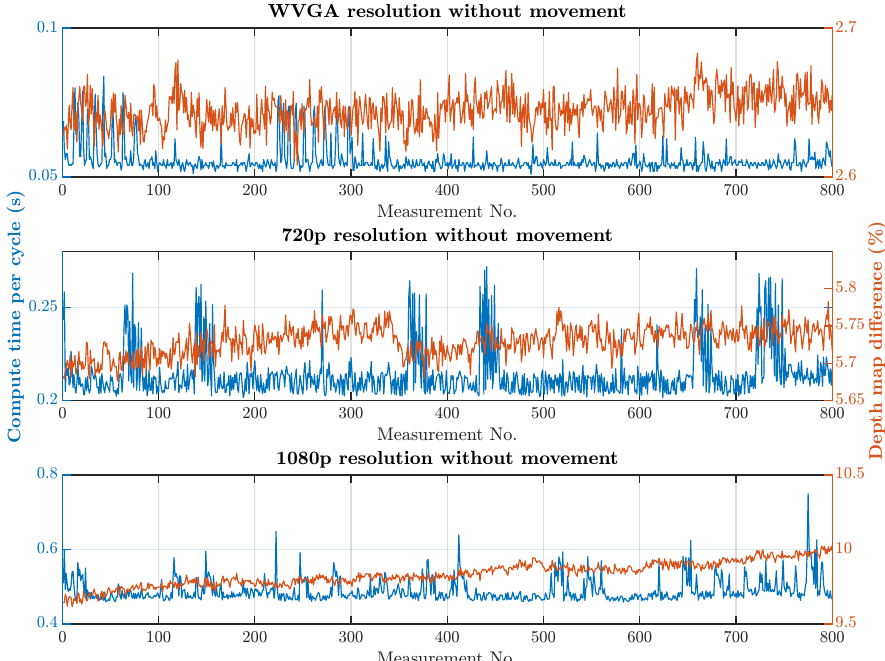
Figure 13. Results without HOG and without movement.